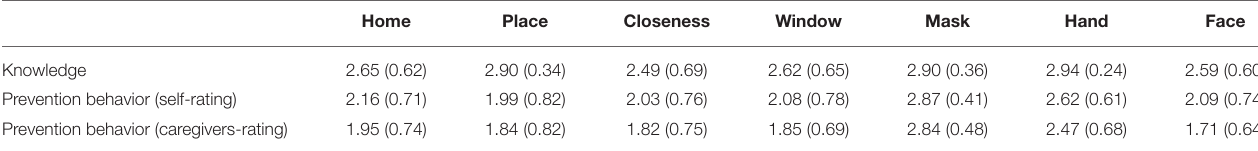
TABLE 8 | Means (standard deviations) of children’s knowledge about COVID-19 and prevention behavior for COVID-19 infection.